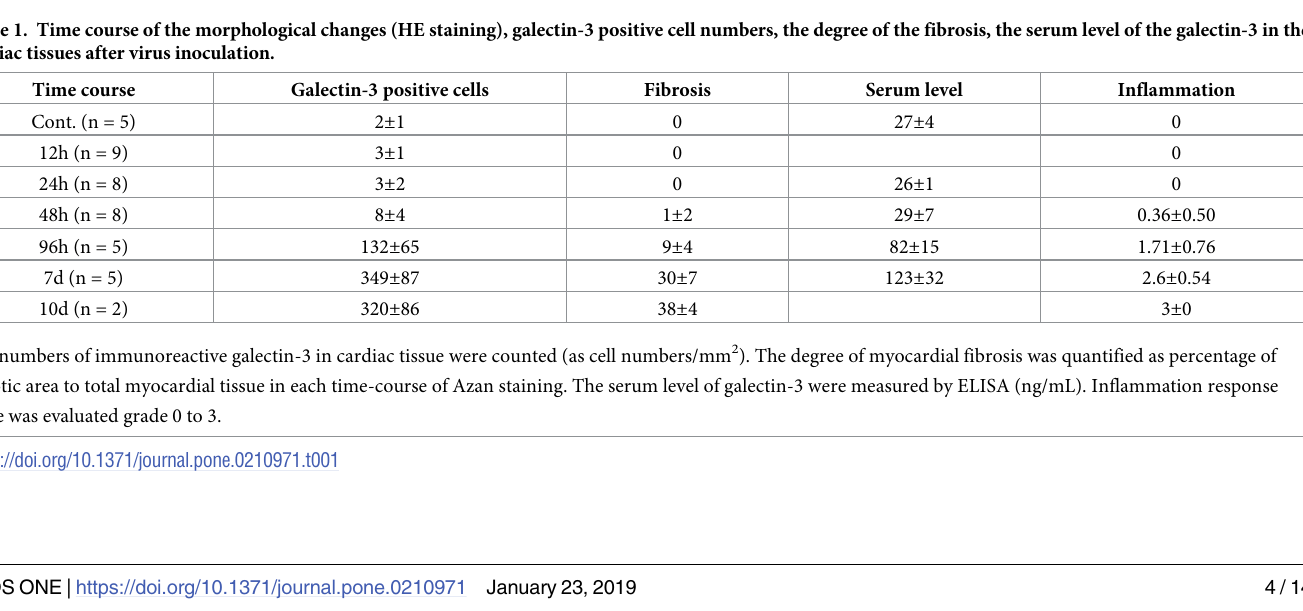
Table 1. Time course of the morphological changes (HE staining), galectin-3 positive cell numbers, the degree of the fibrosis, the serum level of the galectin-3 in the cardiac tissues after virus inoculation. Time course